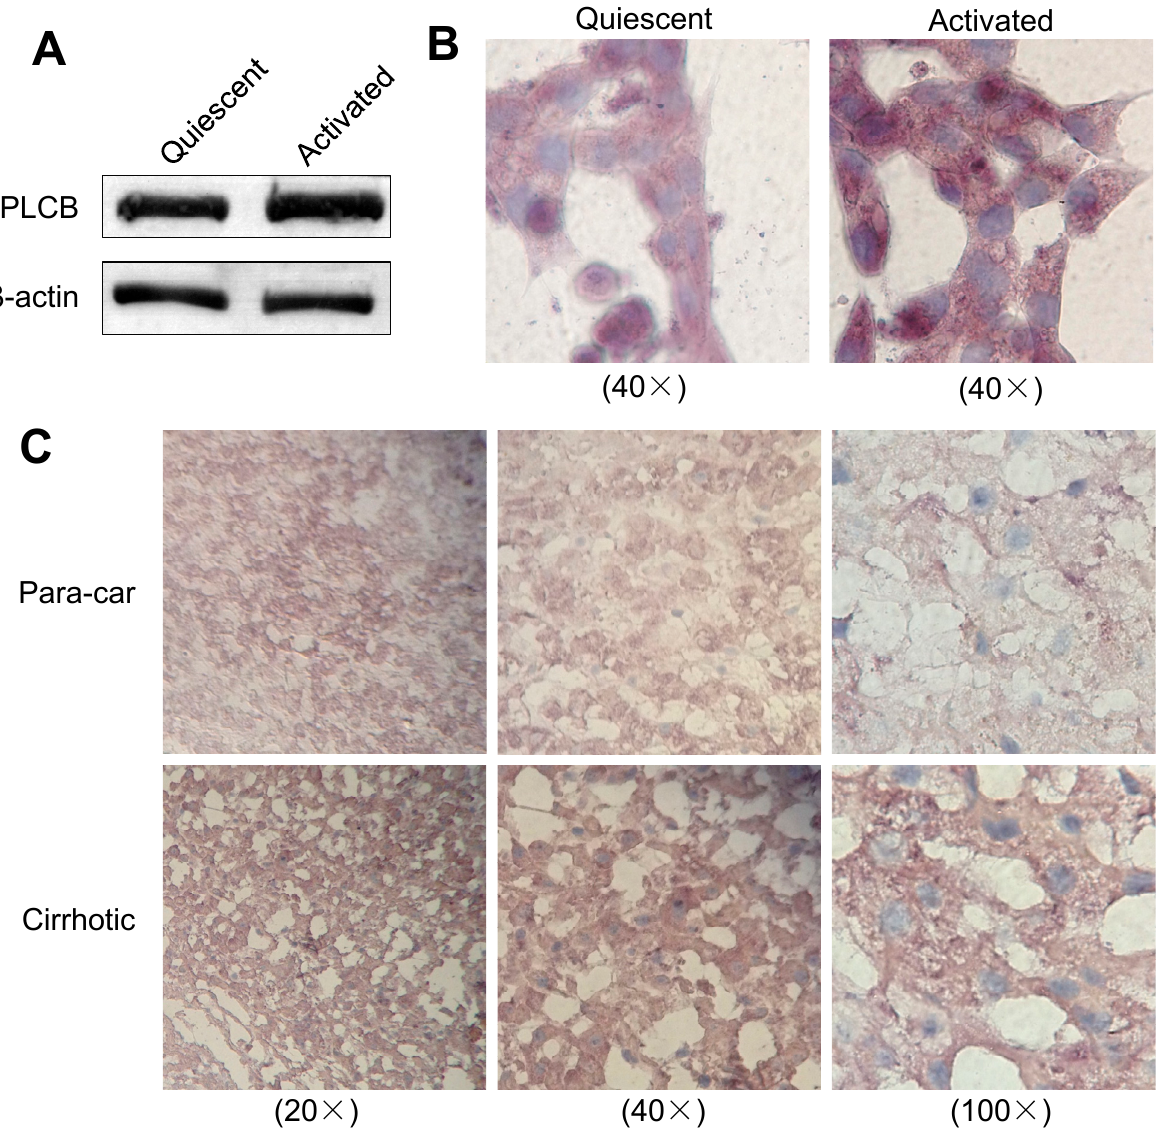
Figure 4. Expression of PLCB2 in the activated LX-2 cells and human liver cirrhosis tissue. ( A ) Western blots showed that the expression of PLCB2 was significantly increased in the activated, compared with quiescent LX-2 cells; ( B ) Immunohistochemistry to validate and investigate the expression and location of PLCB2 in the quiescent and the activated LX-2 cells. The images were shown on the same scale for the quiescent and activated LX-2 cells (images were obtained using a 40× objective lens); ( C ) Immunohistochemistry to investigate the expression and location of PLCB2 in liver cirrhosis tissues and the normal para-carcinoma tissues. The images were taken using 20×, 40×, and 100× objective lenses,